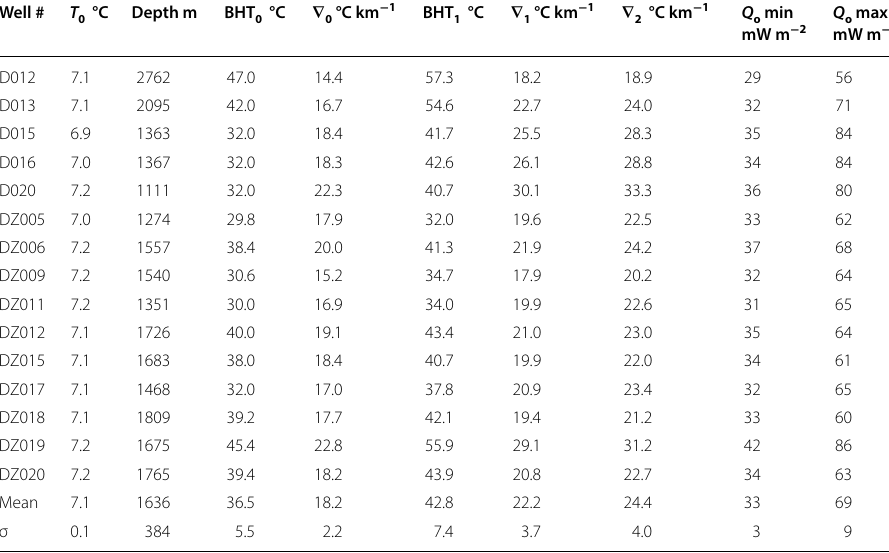
Table 7 BHT data corrections and input